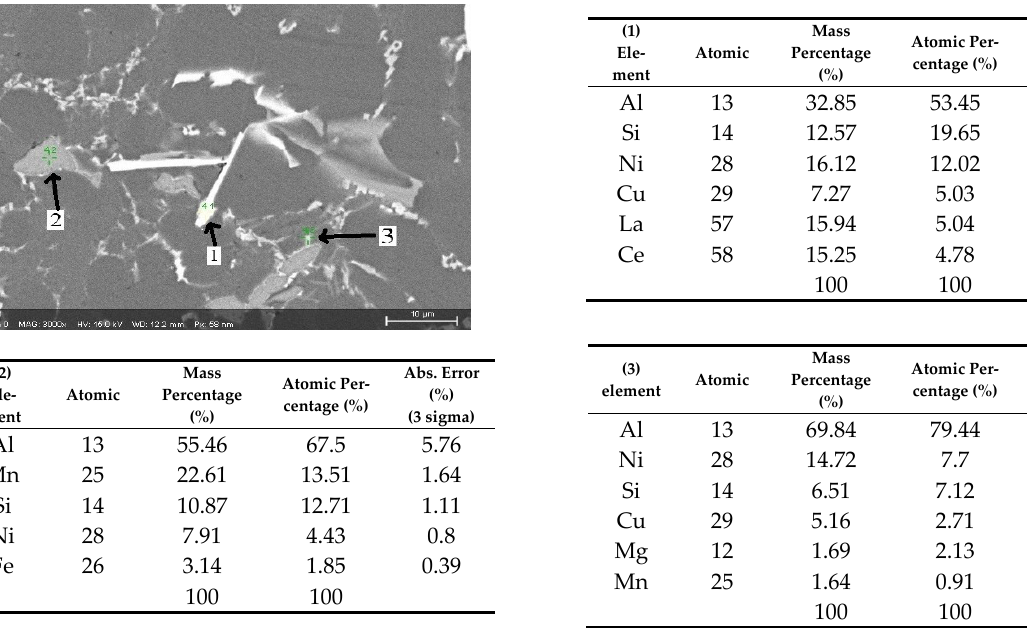
Figure 4. SEM image and EDS analysis results for the 1% (Ce + La) sample.